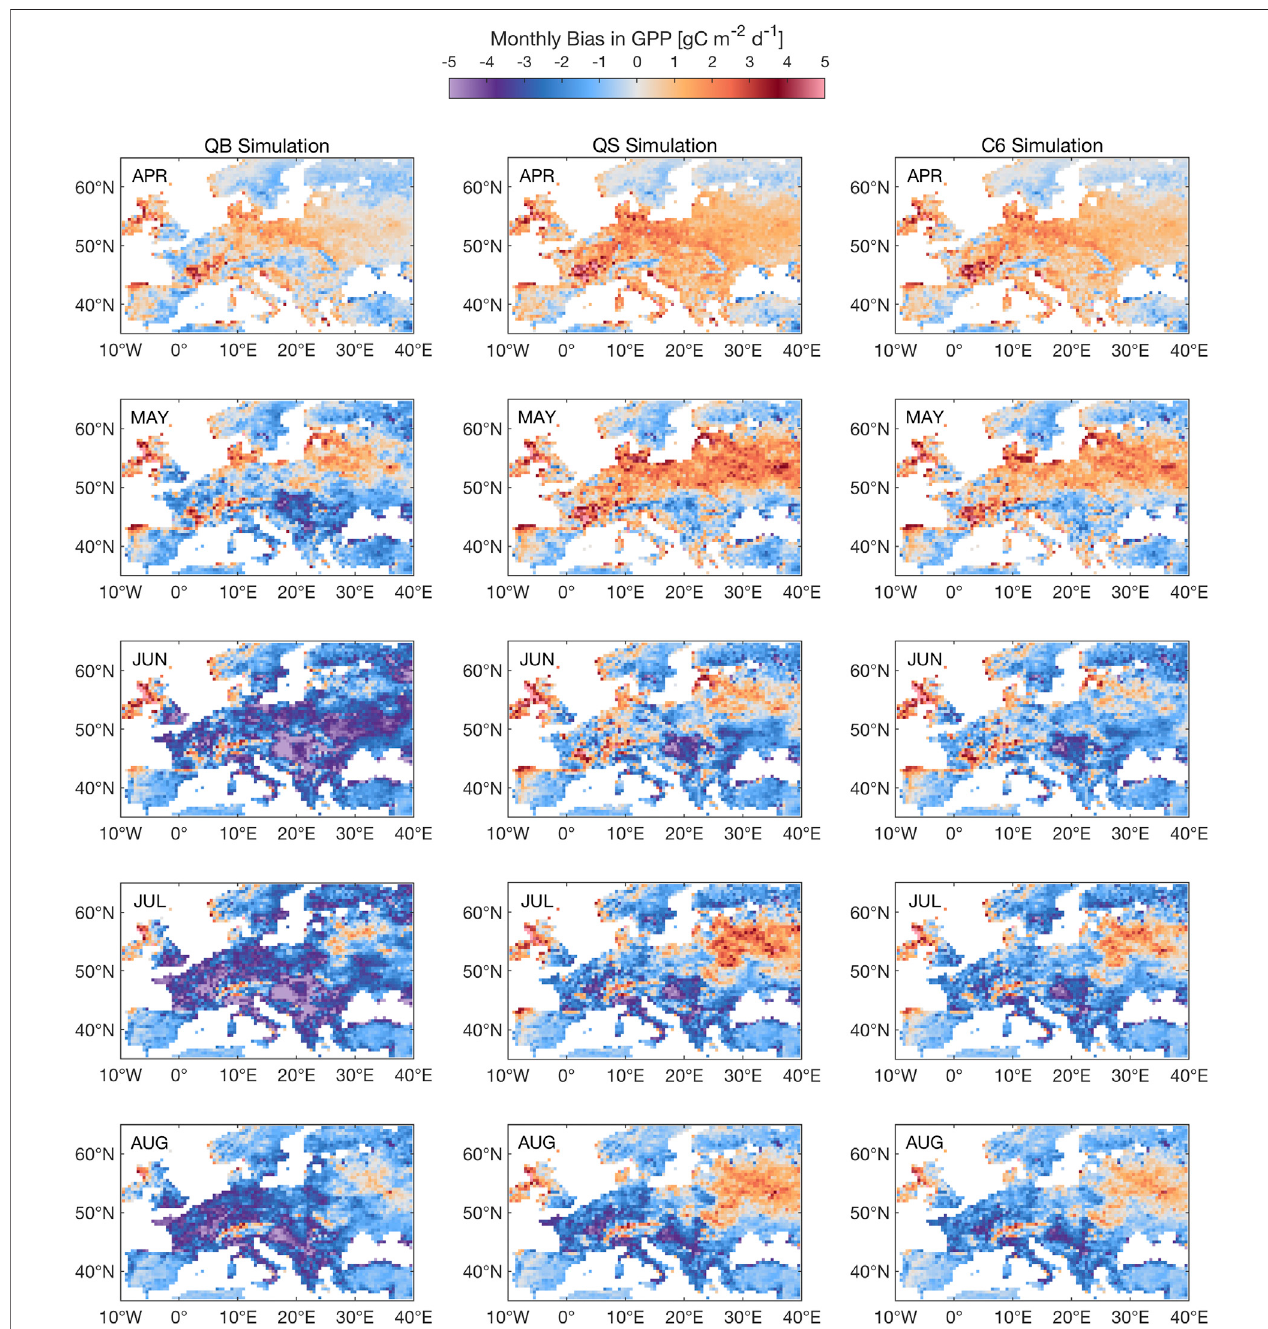
FIGURE9 | Seasonal evolution ofGPP response to the2003 heat wavefor simulation QB, QS, C6, ascompared to FLUXCOM. The 2003season starts at the top row, with the April 2003 monthly mean response, and ends in August 2003, with the monthly mean response. Units: gC m − 2 d − 1 .